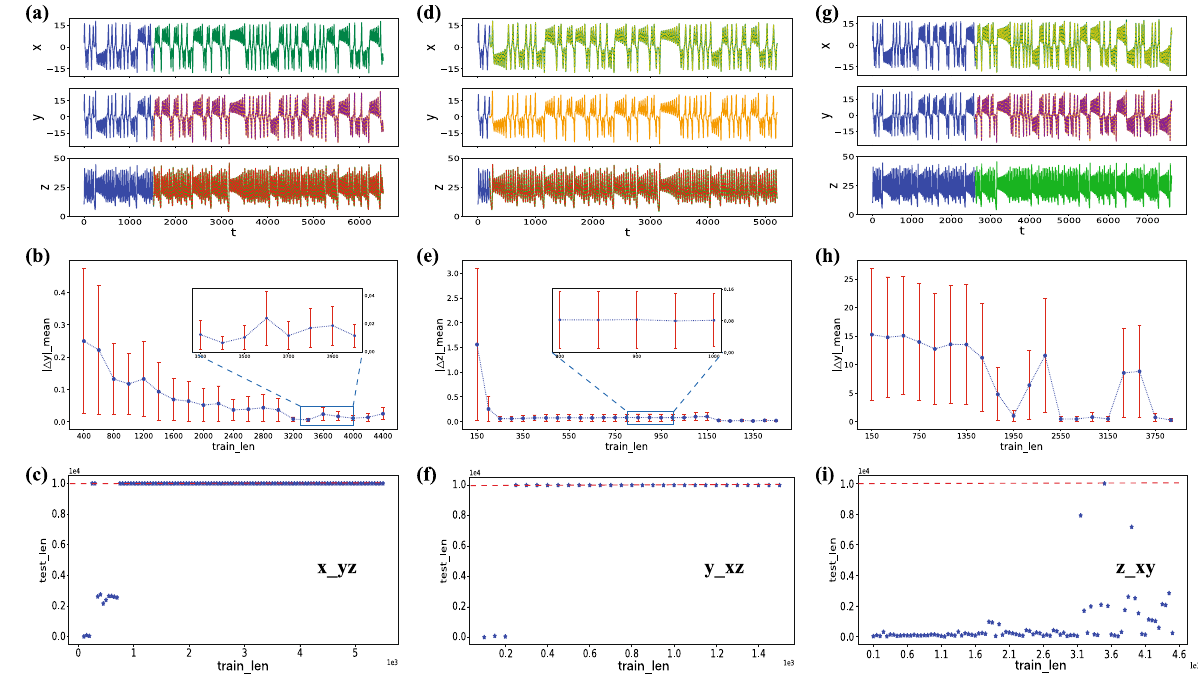
Figure 5. Reconstruction results of the Lorenz system in the corresponding x − yz mode, y − xz mode and z − xy mode. ( a – c ) The sequence diagram, the reconstruction error, and the longest reconstructable length about the x − yz mode, respectively. ( d – f ) The same results obtained in the y − xz mode. Similarly, ( e – i ) The outcomes under the z − xy mode. In ( a , d , g ), the dotted lines are the reconstruction results of the “calibrated” reservoir computing, the real lines are the actual values of system variables (the blue real lines represent the training length). All results represent the “calibrate” model can work well with different modes. ( b , e , h ) The reconstruction error of three modes in the Lorenz system, the front two modes have a sharply declining trend with increasing T train , the reconstruction error of the last mode decreases after reaching a certain training length, but there is some fluctuation. ( c , f , i ) The tendency of longest T test versus T train when RMSE < 0.1. In ( i ), the longest T test does not have a certain threshold, the variables x , y can only be reconstructed accurately by some T train values. The basic reservoir parameters we use here are the same for Figs. 2, 3 and 4.